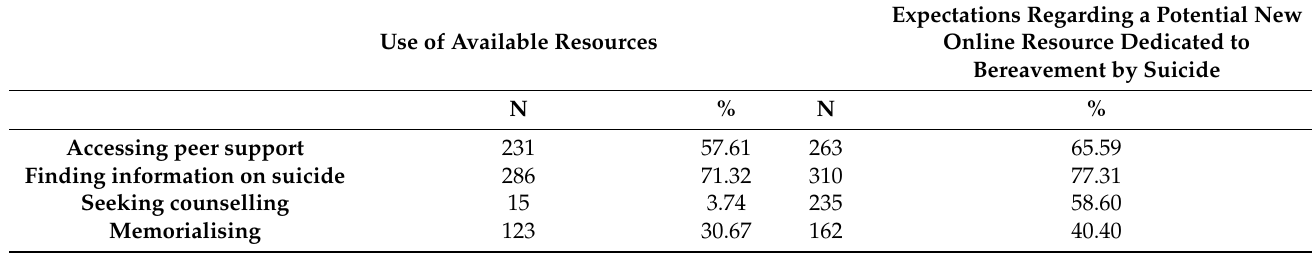
Table 3. Use and expectations regarding online resources dedicated to suicide bereavement.